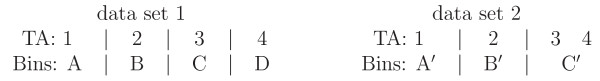
Example of a MicroMerge alignment for two data sets. Data set 1 has four bins, data set 2 has three bins and the data sets are aligned to four theoretical alleles (TA).